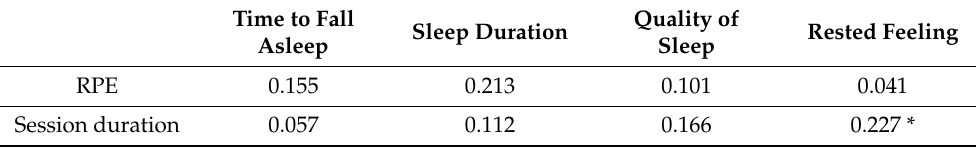
Table 5. Correlation coefficient (r) between training demands and sleep outcomes of the night after training (training * sleep after training). Time to Fall Quality of Sleep Duration Rested Feeling Asleep Sleep RPE 0.155 0.213